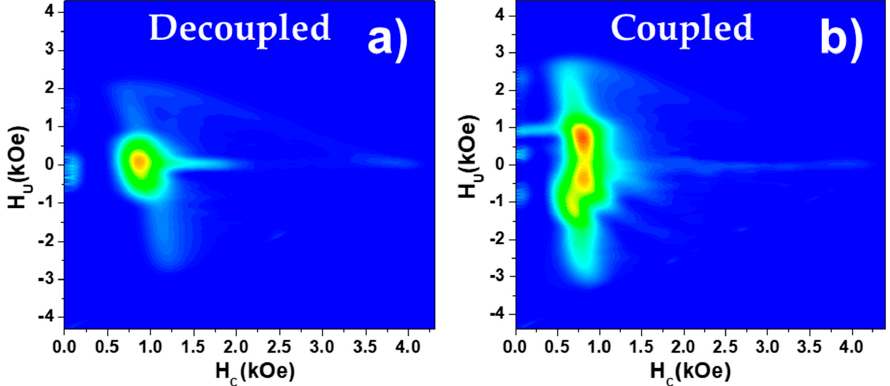
Figure 6. Parallel FORC diagrams, measured along the easy magnetization axis, in decoupled ( a ) and coupled ( b ) Ni/Co nanowire arrays.